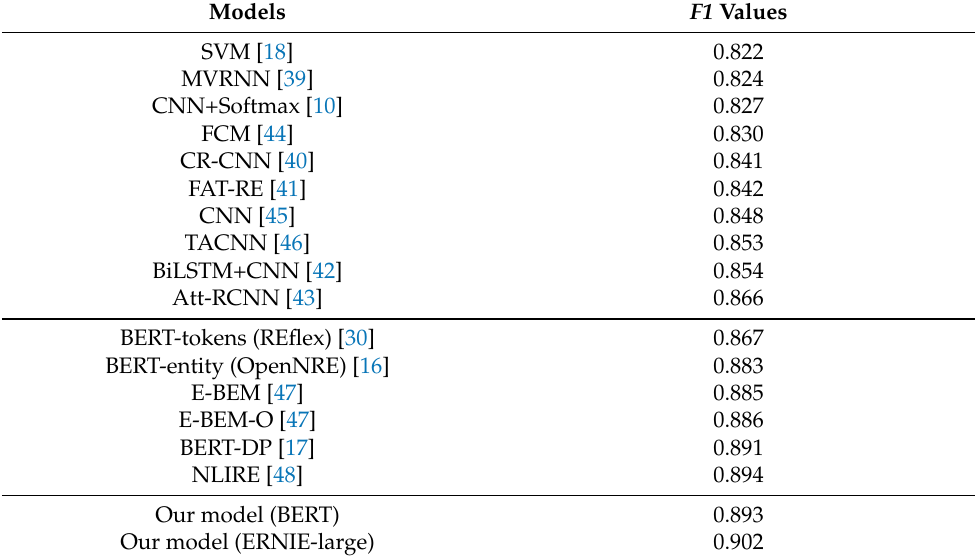
Table 5. The results of different